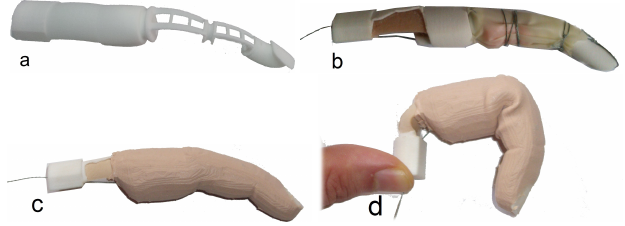
Figure 5. The new fabrication process of the fingers with the second approach—( a ) A 3D printed endoskeleton embeds the elastic MCP joint ( b ) Then the PIP and DIP joints are filled with sponge and covered by an sealing sleeve ( c ) The exterior surface of the finger is formed by casting a resin in the mold ( d ) The finger bending.